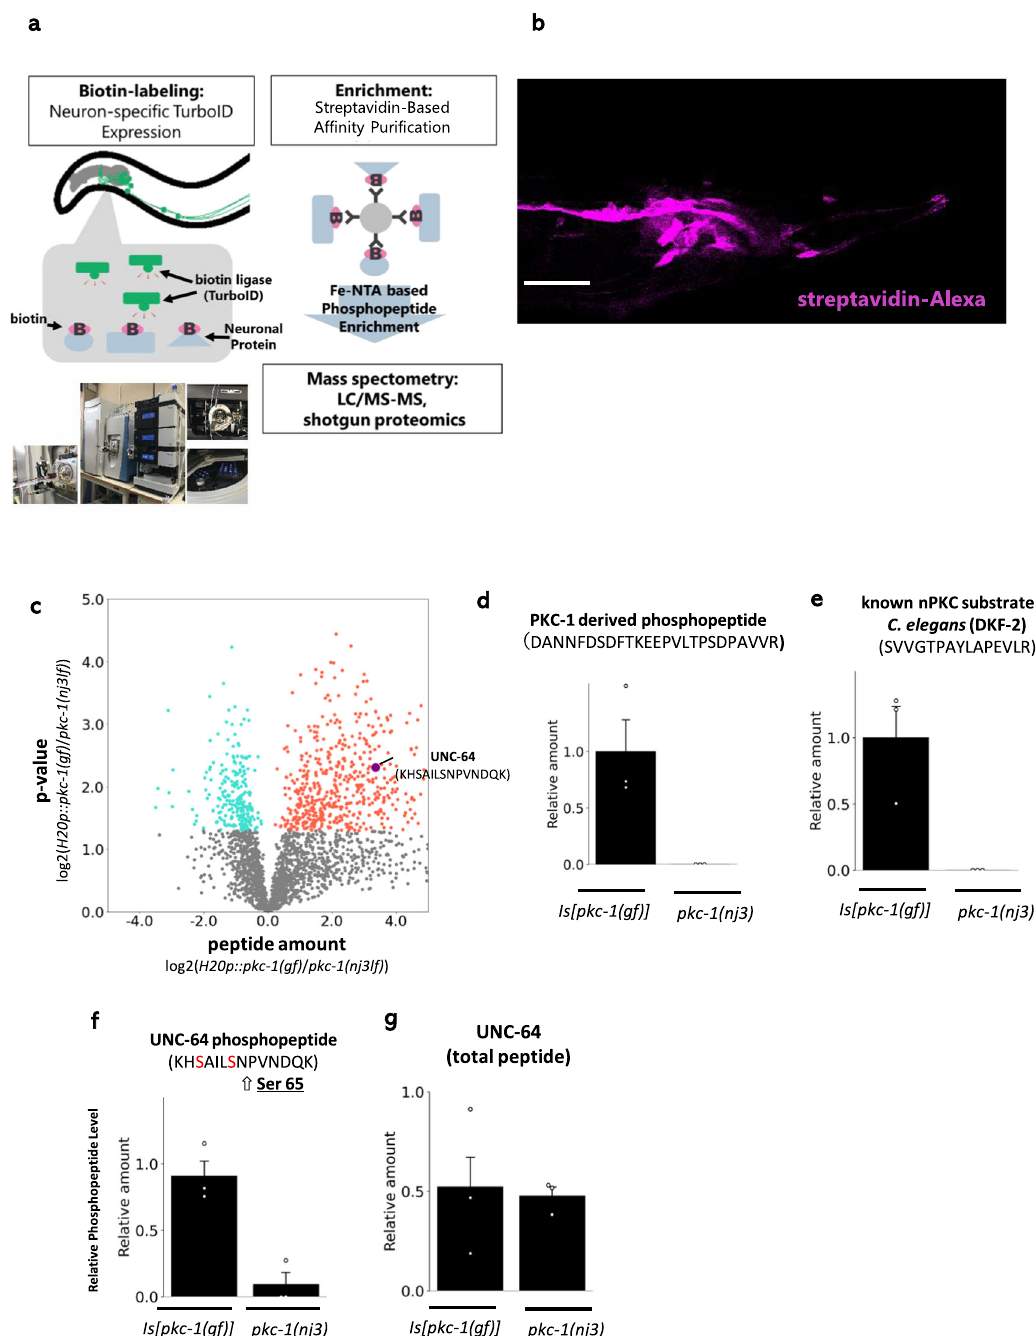
Fig. 2 Neuro-phosphoproteomic analysis using non-speci fi c biotinylation enzyme, TurboID. a Schematic illustration of neuro-phosphoproteomic analysis using TurboID. b Biotin label in rgef-1p :: TurboID was visualized using streptavidin-Alexa. The label appeared to be restricted in the nervous system. At least two animals observed by confocal microscopy showed similar pattern, with multiple animals appeared to be similarly stained under fl uorescence microscopy. Scale bar: 40 µ m. c Results of neuro-phosphoproteomic analysis. pkc-1(nj3[W218stop], loss of function) and pan-neuronal H20p::pkc-1(A160E gain of function) -expressing strains were compared. Volcano plot of phosphoproteomic analysis. Red and blue dots represent upregulated and downregulated ( P < 0.05 in two-sided t-test) phosphopeptides, respectively, in pkc-1(gf) expressed strains, compared to pkc-1(nj3lf) mutants. Other phosphopeptides are indicated as gray dots. The purple dot represents the peptide KHSAILSNPVNDQK, which is mapped onto UNC-64. The average of the triplicates ( n = 3 independent experiments) is described. Peptides which were not detected in either strains were not represented. d The amount of phosphopeptides derived from PKC-1. e The amount of phosphopeptides from a known PKC substrate, DKF-2. f The amount of phosphopeptides containing UNC-64 Ser65. g The amount of total peptides containing UNC-64. Error bars indicate SEM for all panels in Fig. 2. Source data are provided as Supplemental